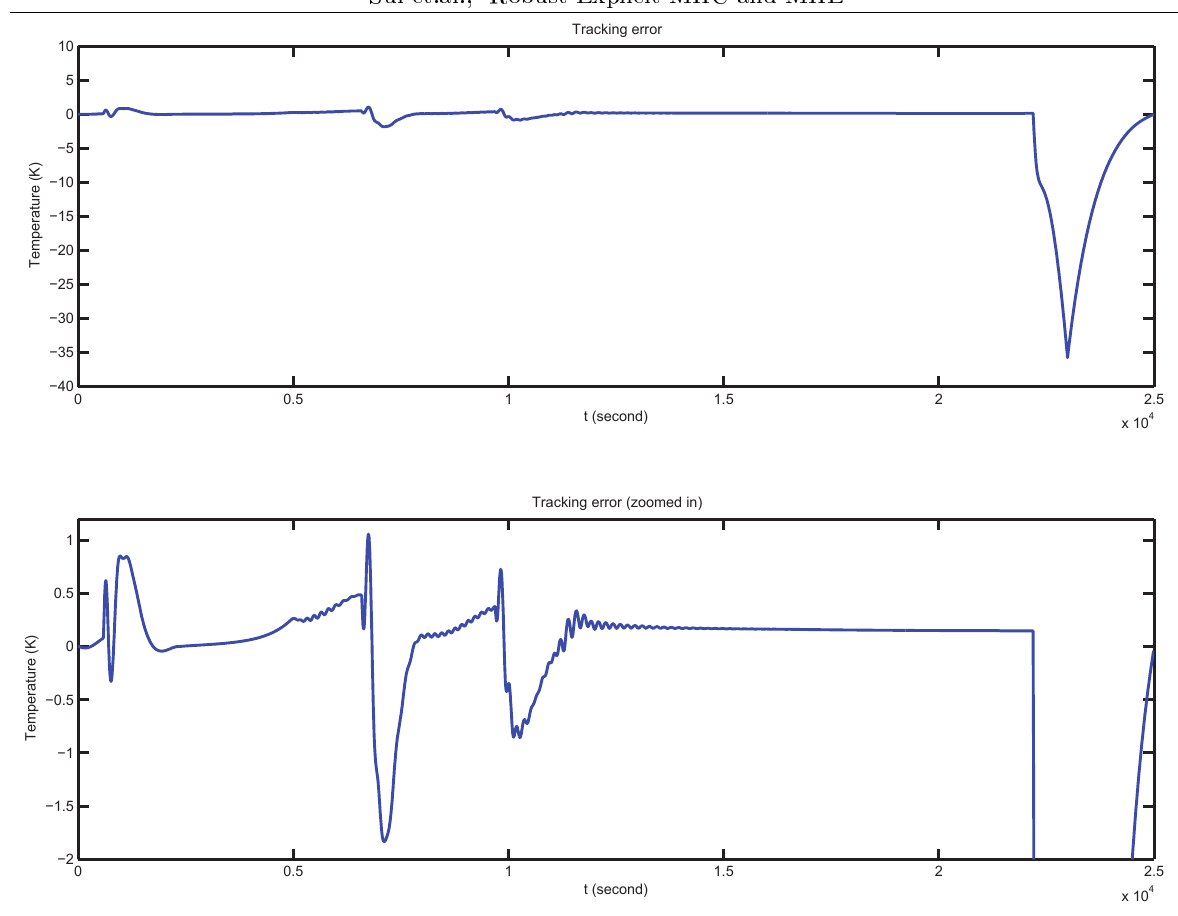
Figure 2: Tracking error to the optimal temperature